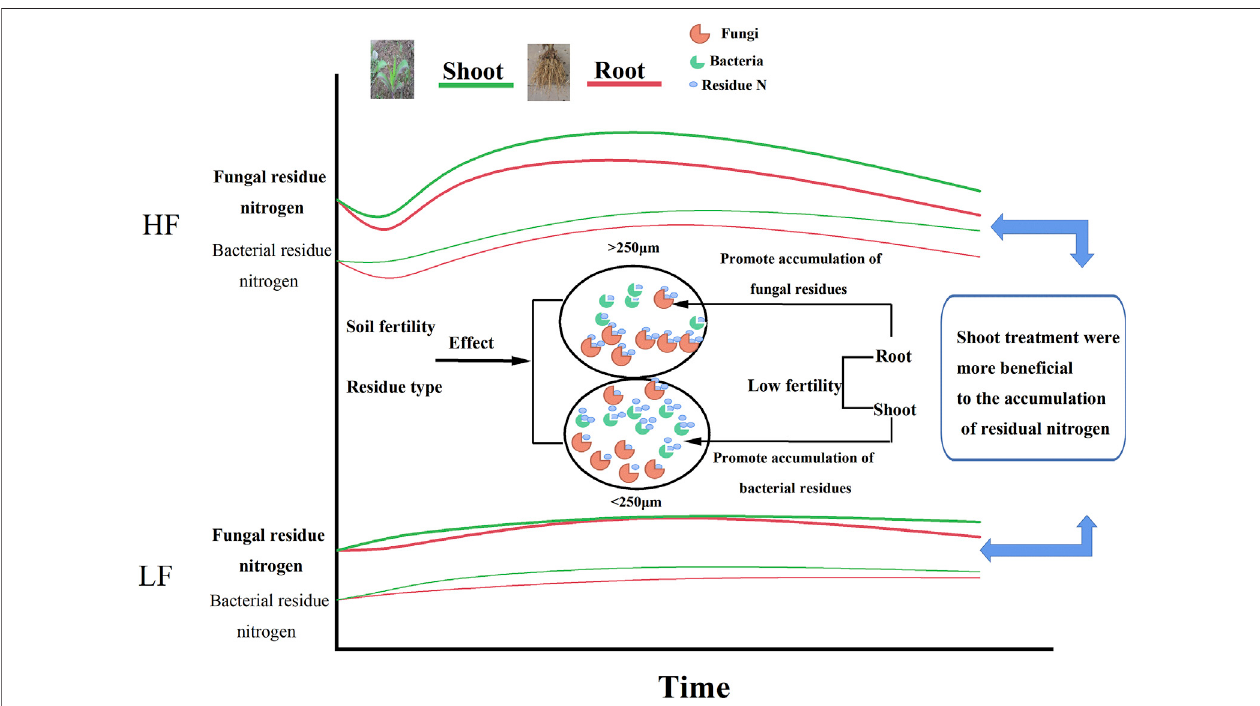
FIGURE9| Schematicdiagramofthein fl uenceofthemaizeresiduetypeandsoilfertilityonnitrogenallocationofmicrobialresiduesinaggregates.Note:thecurves represent the changes of fungal and bacterial residual N in different soil aggregates with different soil fertilities over incubation time. The black circles represent aggregates. The shapes within the circles represent microbial communities; meanwhile, the orange and green shapes inside the circles represent fungi and bacteria, respectively. The small blue circle represents microbial residual N.